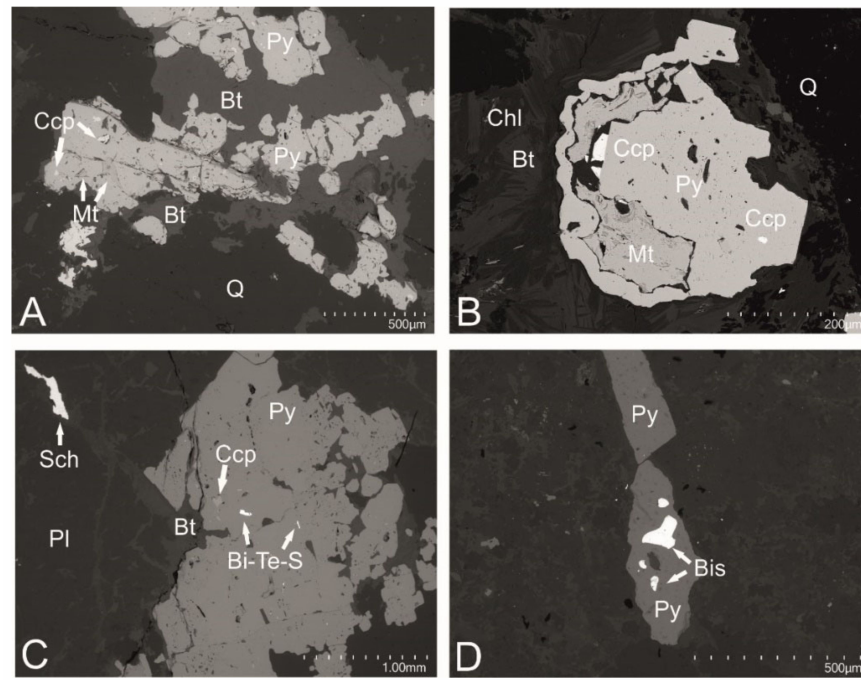
Figure 2. ( A – D ) SEM back-scattered images of Py-I (early, skarn-forming stage of mineralization). ( A ) Pyrite intergrown with biotite, ( B ) Pyrite intergrown with magnetite and associated with biotite and chlorite, ( C ) Pyrite with inclusions of Bi-tellurosulfides, ( D ) Pyrite with inclusions of bismuthinite.